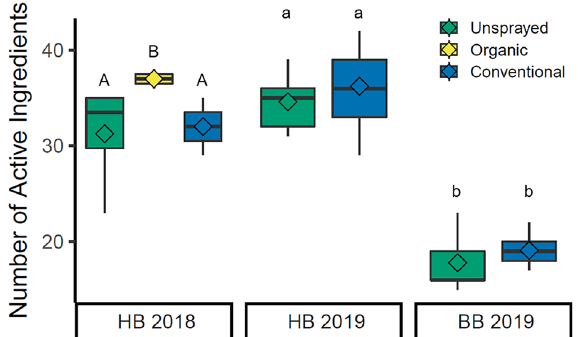
Figure 1. Average number of active ingredients (AIs) detected at each farm. Dark lines indicate the median, diamonds indicate the mean, boxes represent the upper and lower quartile, whiskers indicate the maximum and minimum number of AIs detected. Data are separated by which bee collected the pollen ( HB honey bee, BB bumble bee) and in which year the data were collected. Upper case letters indicate significant differences within the 2018 data, and lower case letters indicate significant differences within the 2019 data. Graph created in R 30 v3.6.2 with the package ggplot2 43 .